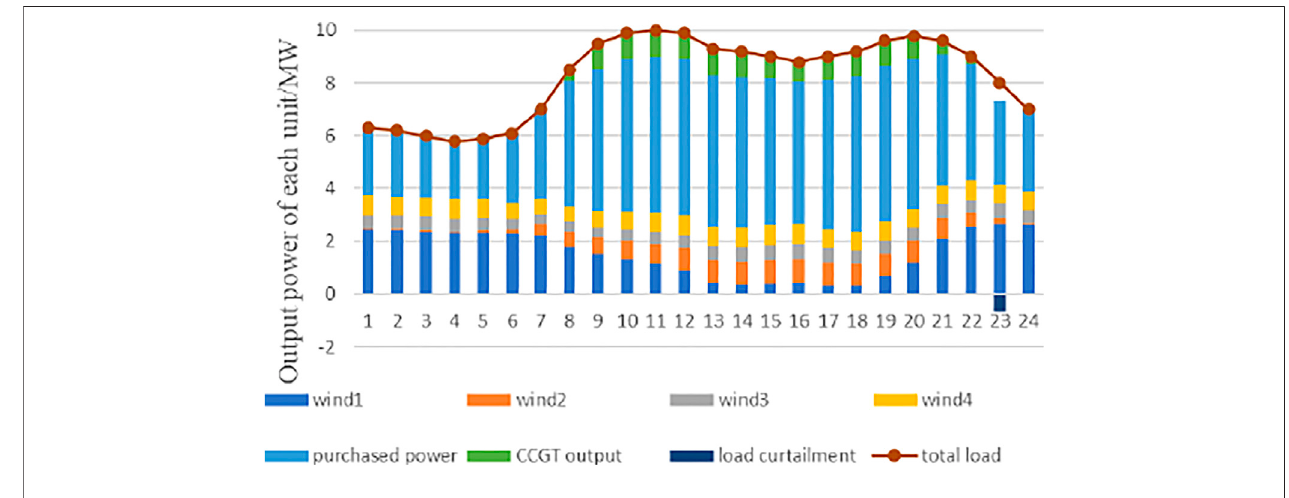
FIGURE 10 | Optimal generator outputs of case 1.